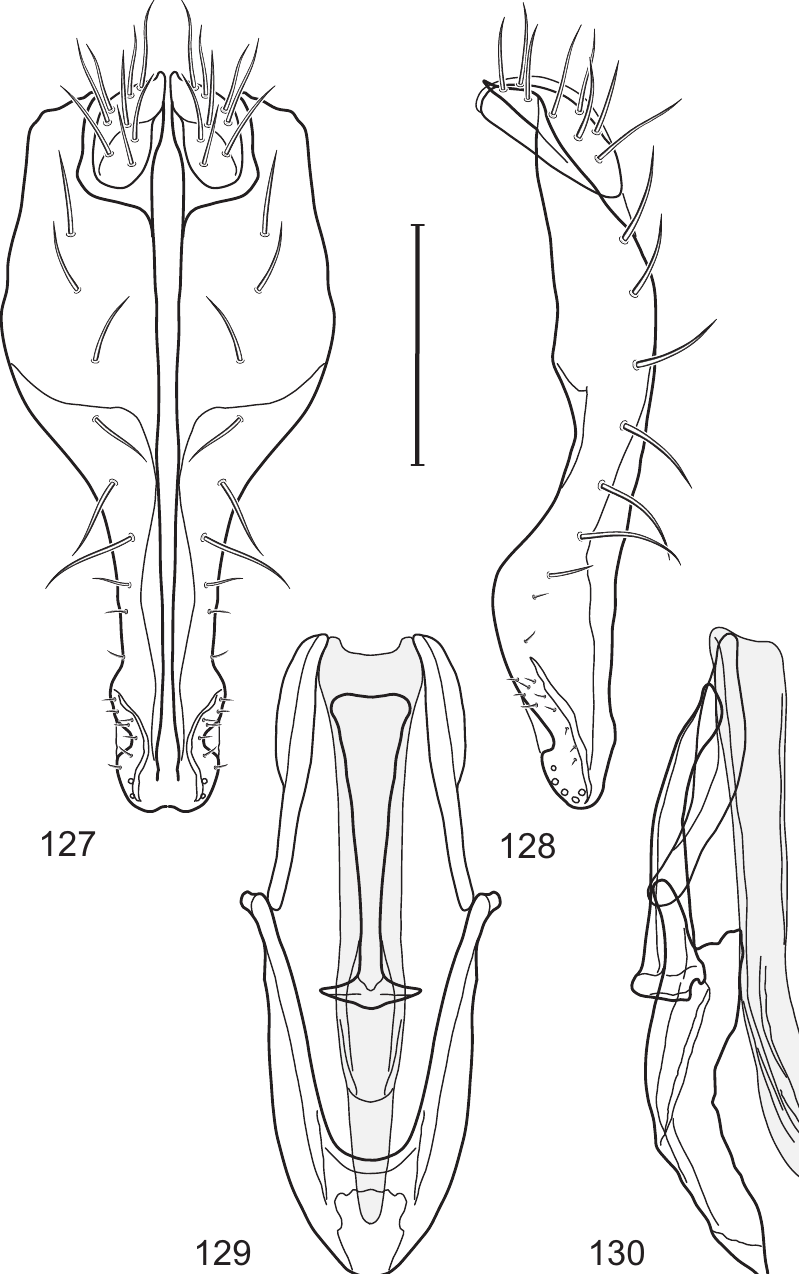
Figures 127–130. Hydrochasma urnulum sp. n. (Dominican Republic. Barahona: Baoruco - beach and river) 127 epandrium and cerci, posterior view 128 same, lateral view 129 internal structures of male terminalia (aedeagus [shaded], phallapodeme, gonite, hypandrium), ventral view 130 same, lateral view. Scale bar = 0.1